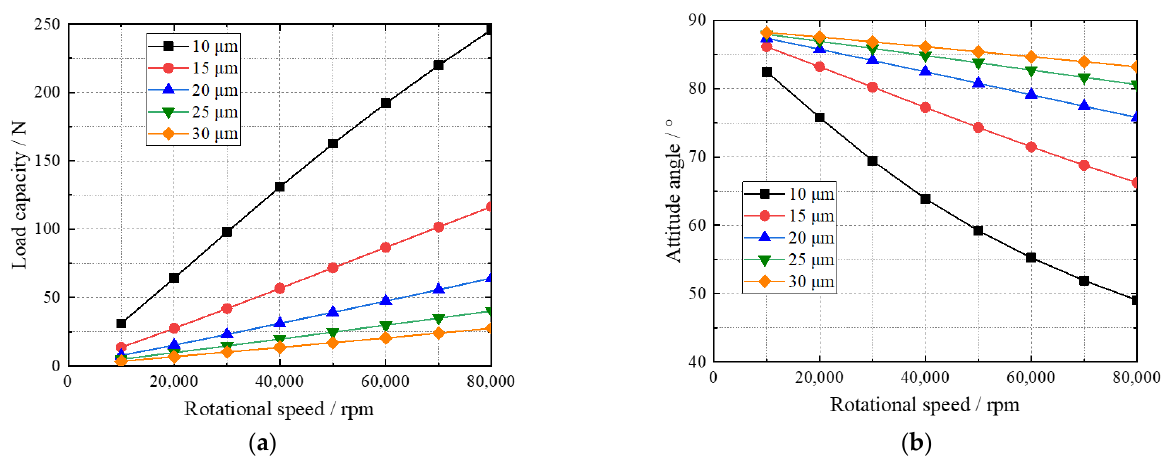
Figure 12. ( a ) Bearing load capacity and ( b ) attitude angle of hydrogen gas bearings with gas film clearance.